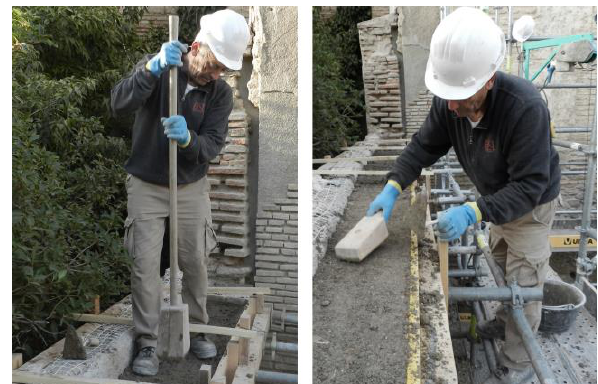
Figure 9. Detail of the previous state of the rammed earth wall with the presence of a void. Punctual formwork and ramming